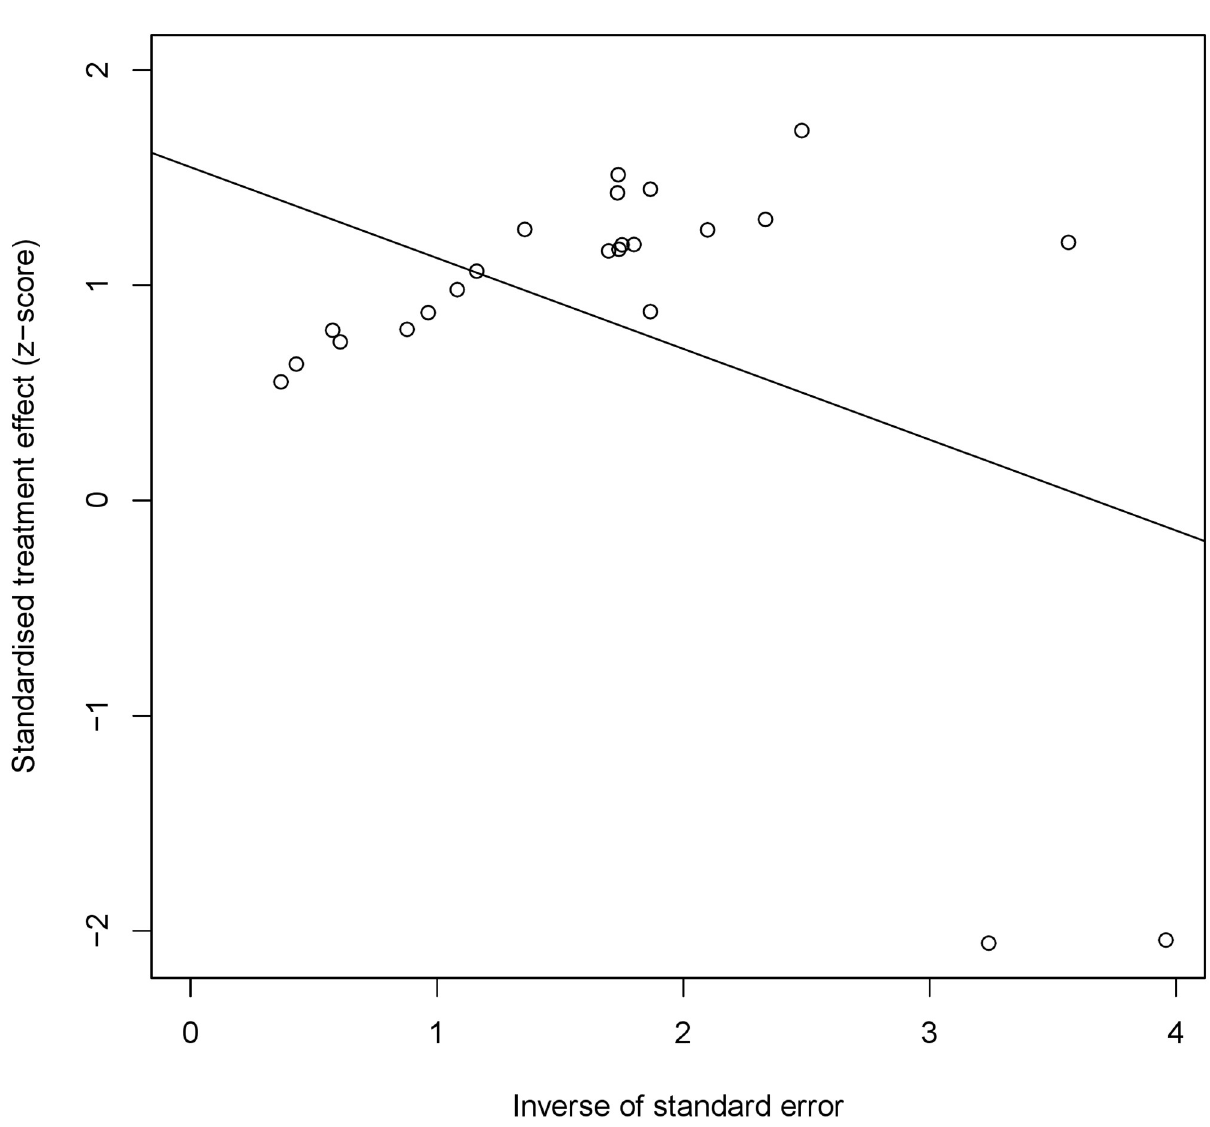
Fig 7. Result of Egger’s test. Egger’s test proved the possibility of publication bias (P < 0.05). Each point represents a separate study for the indicated